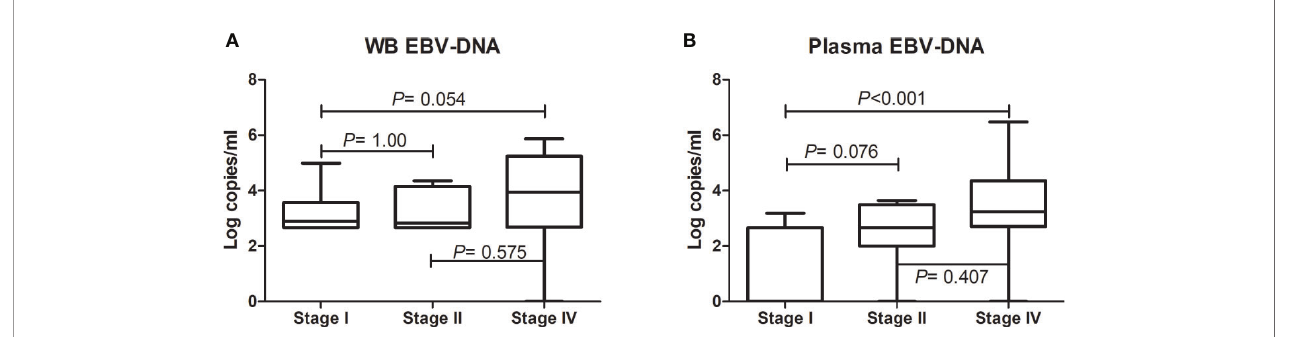
FIGURE 1 | Comparative analysis of pre-treatment Epstein-Barr virus (EBV)-DNA loads in whole blood and plasma according to disease stage. EBV-DNA levels in (A) whole blood and (B) plasma according to disease stage. The bars show mean values and the error bars show standard